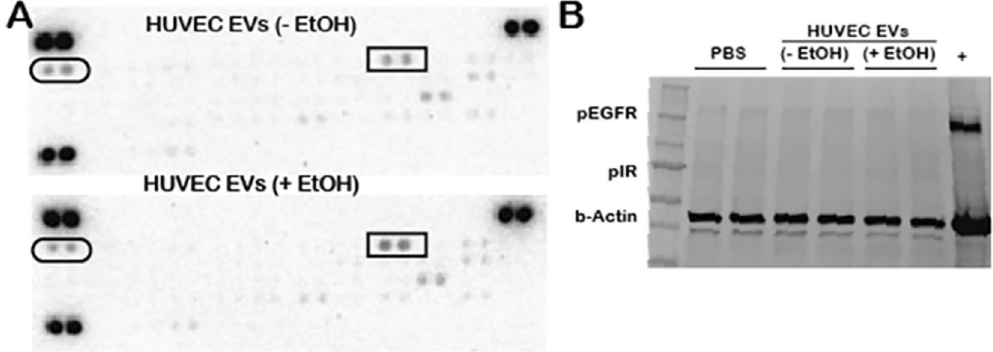
Figure 4. Endothelial cell receptor tyrosine kinase stimulation by EVs. ( A ) Phosphorylated RTK arrays were incubated for 30 min with lysates from recipient HUVECs stimulated by 100 µ g/ml EVs from producer HUVECs cultured in the presence or absence of 100 mM ethanol (EtOH) for 24 h. Ovals indicate phospho- epidermal growth factor receptor (pEGFR) and rectangles indicate phosphor-insulin receptor (pIR). Blots shown are representative of three independent experiments. ( B ) The same conditions were used to generate separate immunoblots for pEGFR and pIR using different antibodies (n = 3; H1975 cells were used as a positive control for pEGFR ( +